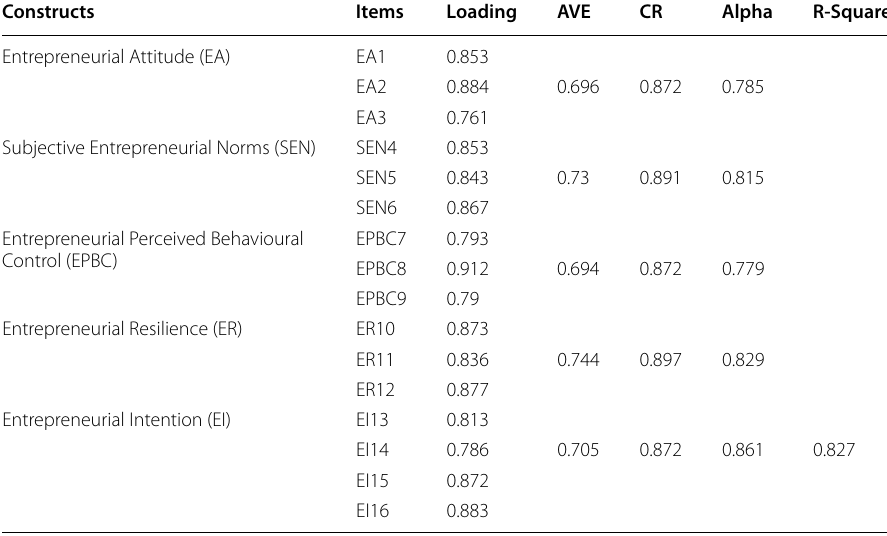
Table 4 Measurement of model assessment